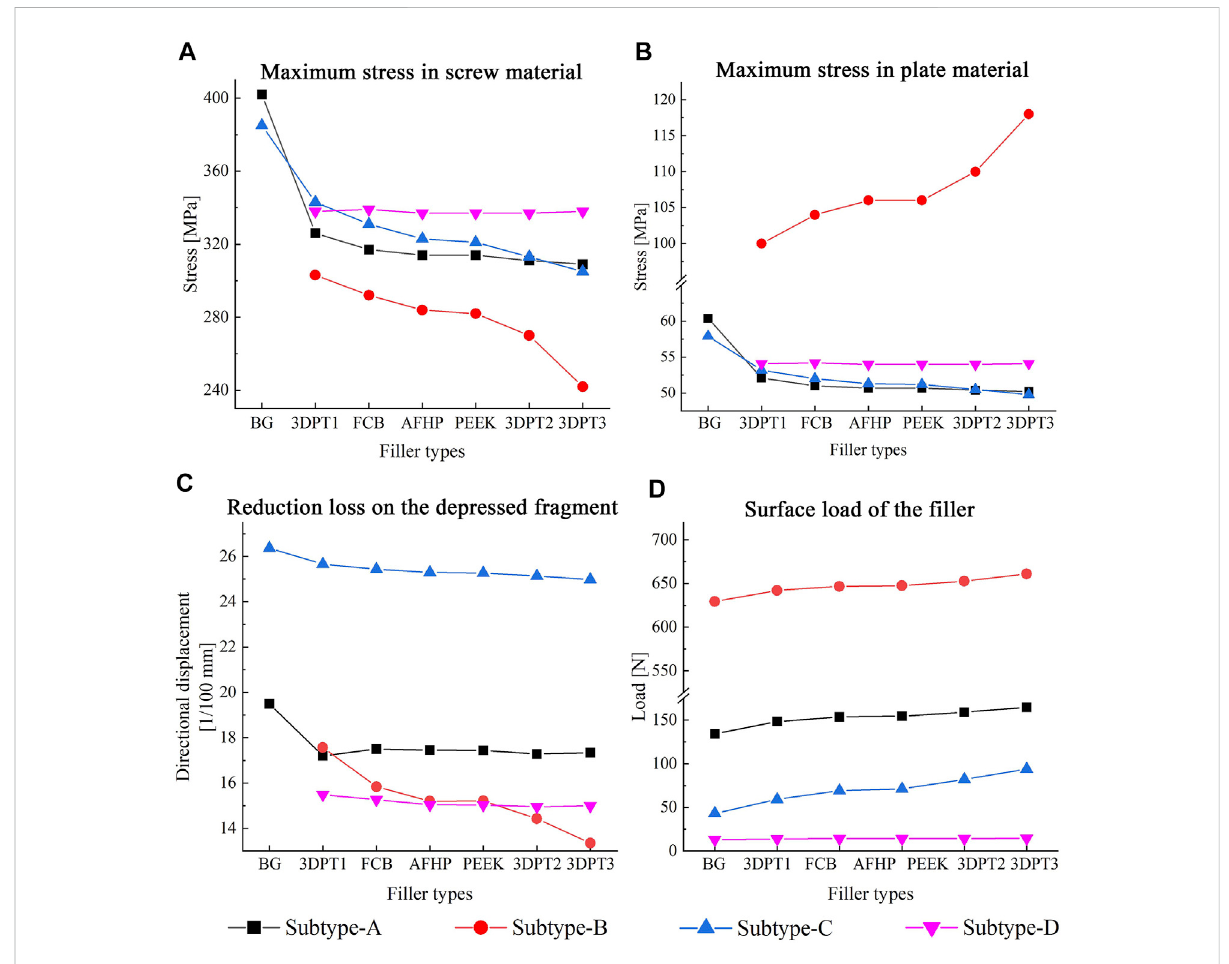
FIGURE 5 Maximum valueandvariation trendofscrew material stressandplate materialstress (A,B) ,reductionloss on thedepressedfragmentexpressed as directional displacement (C) , and the surface load of the fi ller (D)